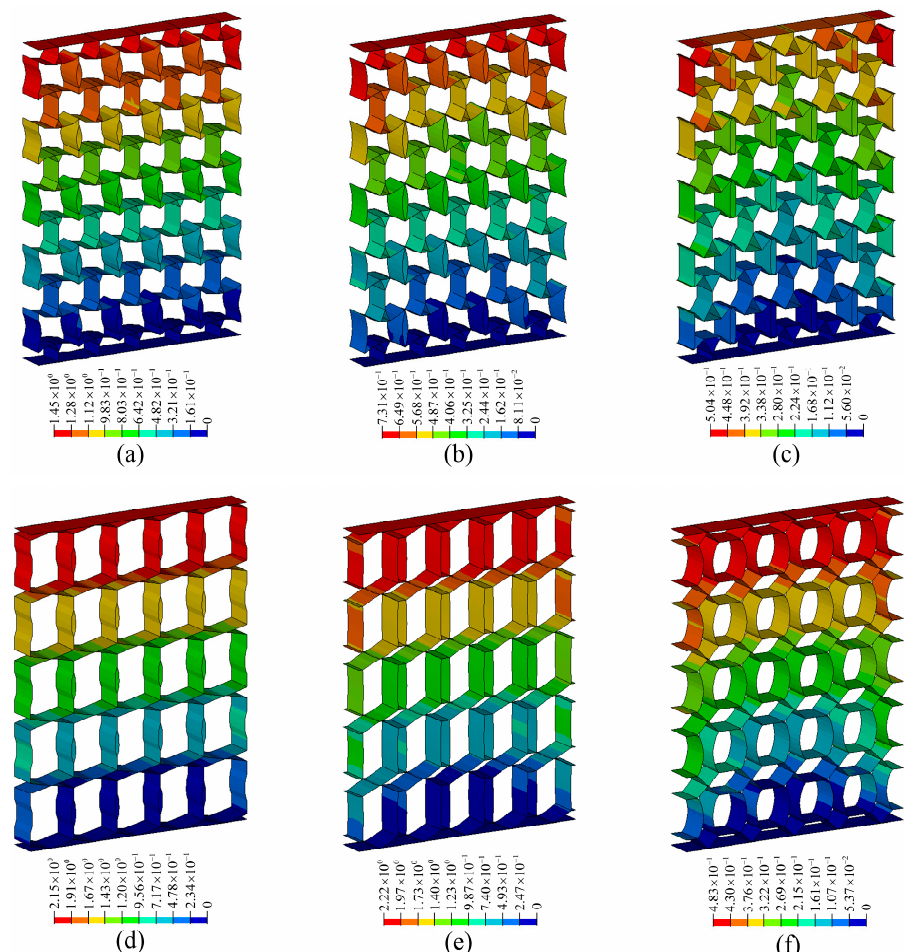
Figure 10. Displacement contours of metamaterials corresponding to various PR values: ( a ) ν = − 0.3; ( b ) ν = − 0.6; ( c ) ν = − 1.0; ( d ) ν = + 0.3; ( e ) ν = + 0.6; ( f ) ν = + 1.0.